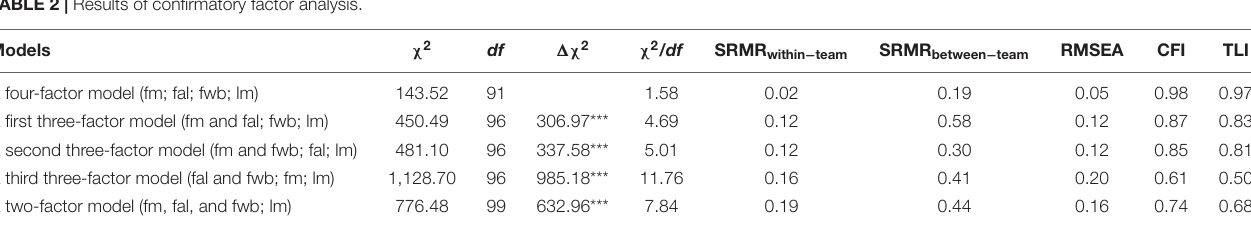
TABLE 2 | Results of confirmatory factor analysis.